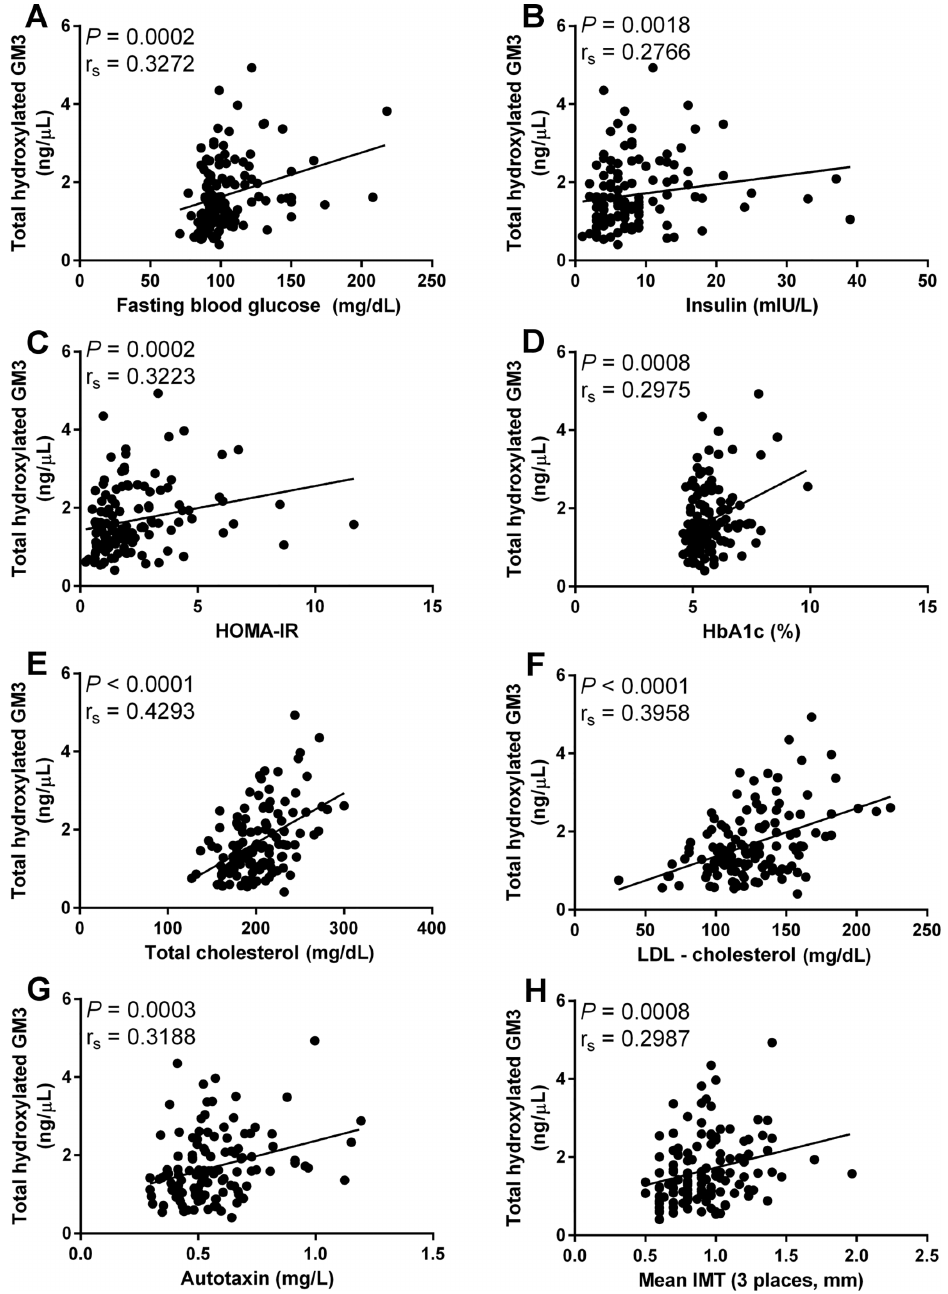
Fig 5. Association between metabolic disease risk factors and total hydroxylated GM3. Correlation of total hydroxylated GM3 molecular species with fasting blood glucose (A), insulin (B), HOMA-IR (C), HbA1c (D), total cholesterol (E), LDL-c (F), autotaxin (G) and mean IMT (H). Spearman ’ s rank correlation was used to access correlation between total hydroxylated GM3 molecular species and metabolic disease risk factors. All correlations were deemed significant with P values below